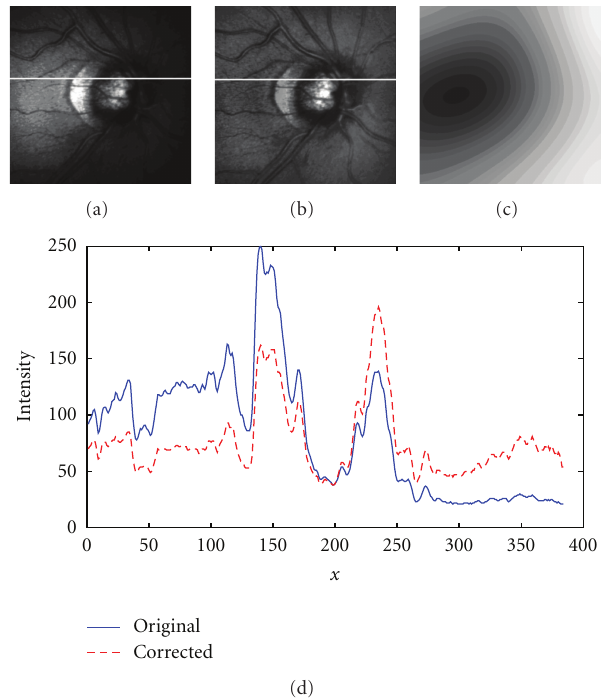
Figure 9: (a) Retinal image highly corrupted by non-homogenous illumination, (b) Image after multiplicative correction by recovered bias field, (c) Normalized bias field controlled by 3 × 3 parameters automatically obtained using proposed algorithm, (d) Intensity profiles along the indicated row.